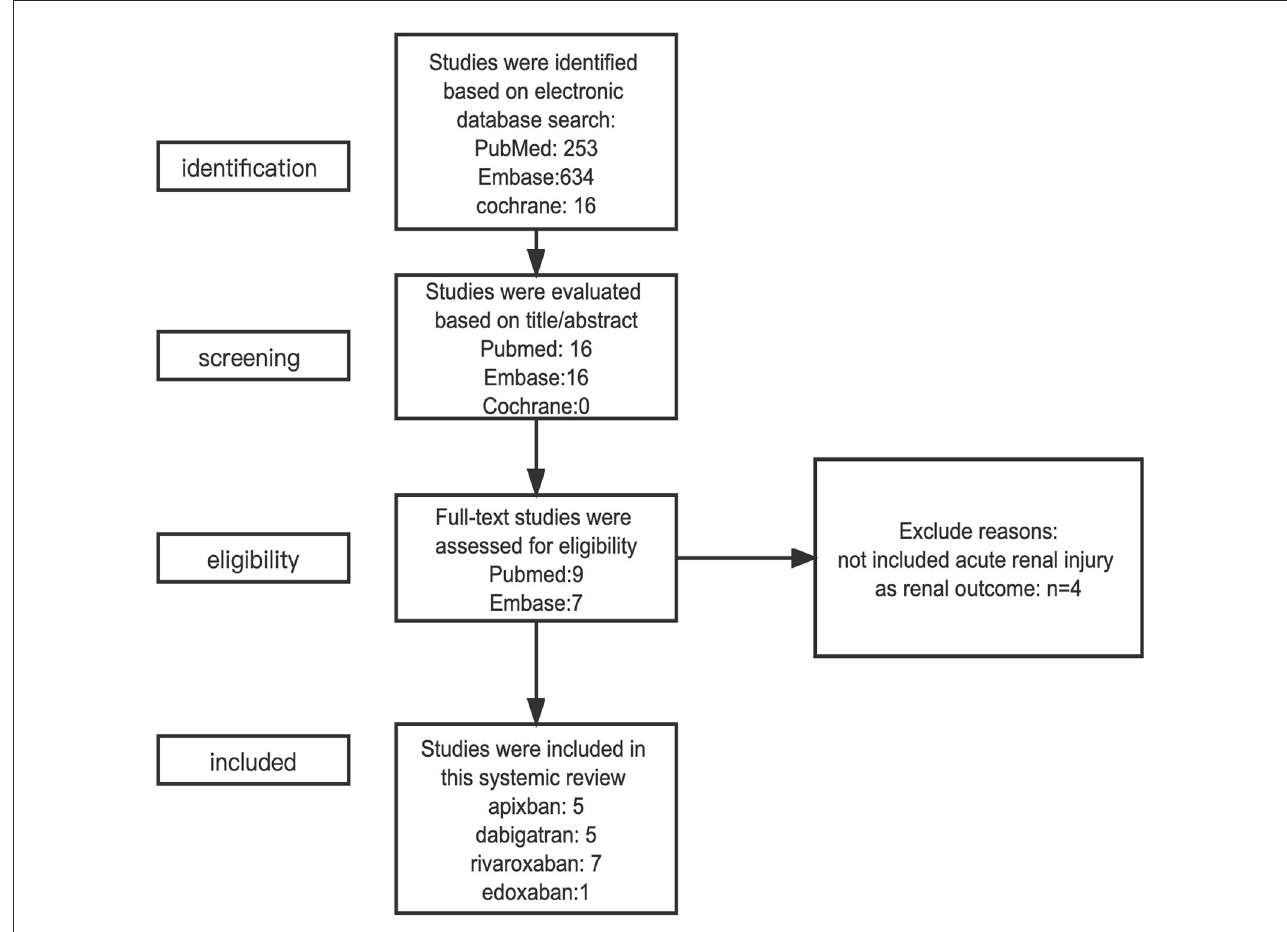
FIGURE1 The process of selecting eligible